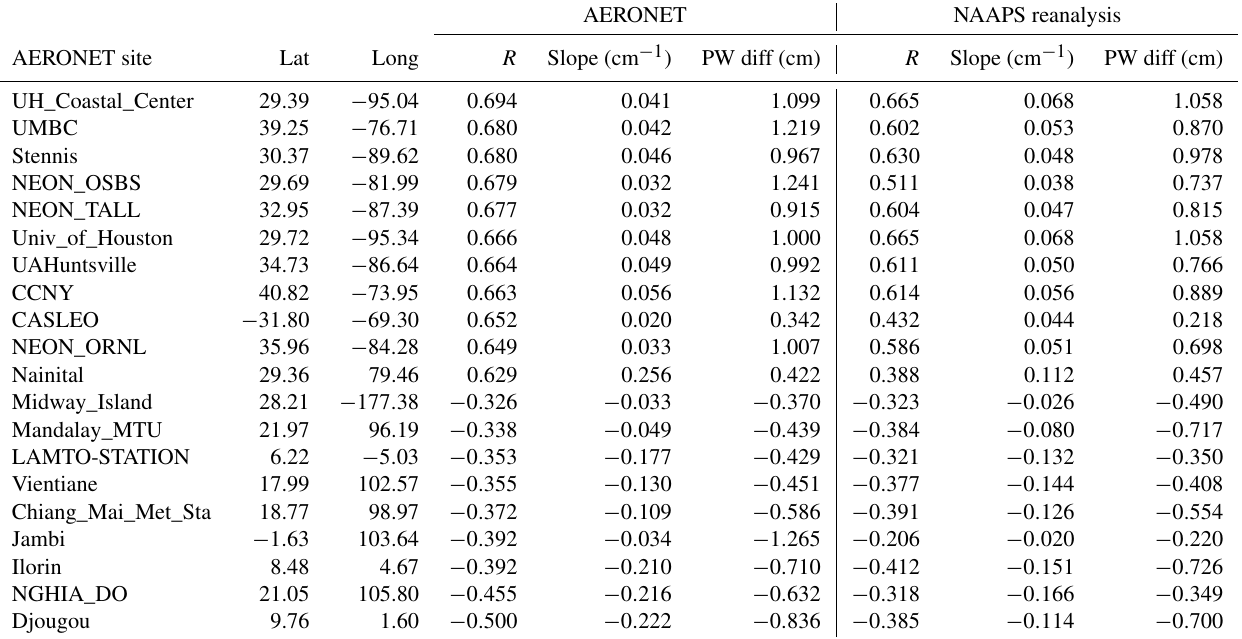
Table 2. AOD and PW relationship evaluation results for MAM at select AERONET sites that exhibited the strongest AERONET corre- lations, positive and negative. The site name and latitude–longitude information are shown, as well as the correlation ( R ), the change in AOD with PW (slope), and the statistically significant difference in mean PW for high-AOD events (PW diff) for both AERONET and the